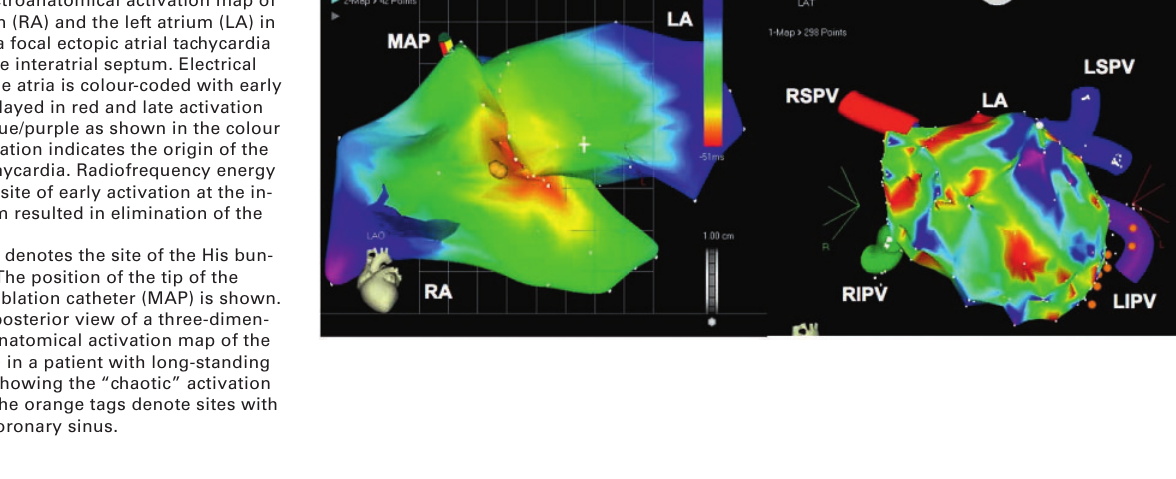
Left: Left anterior oblique view of a three-di- mensional electroanatomical activation map of the right atrium (RA) and the left atrium (LA) in a patient with a focal ectopic atrial tachycardia arising from the interatrial septum. Electrical activation of the atria is colour-coded with early activation displayed in red and late activation displayed in blue/purple as shown in the colour bar. Early activation indicates the origin of the focal atrial tachycardia. Radiofrequency energy delivery at the site of early activation at the in- teratrial septum resulted in elimination of the tachycardia. The yellow dot denotes the site of the His bun- dle recording.The position of the tip of the mapping and ablation catheter (MAP) is shown. Right: Antero-posterior view of a three-dimen- sional electroanatomical activation map of the left atrium (LA) in a patient with long-standing persistent AF showing the “chaotic” activation pattern of AF.The orange tags denote sites with CFAEs in the coronary